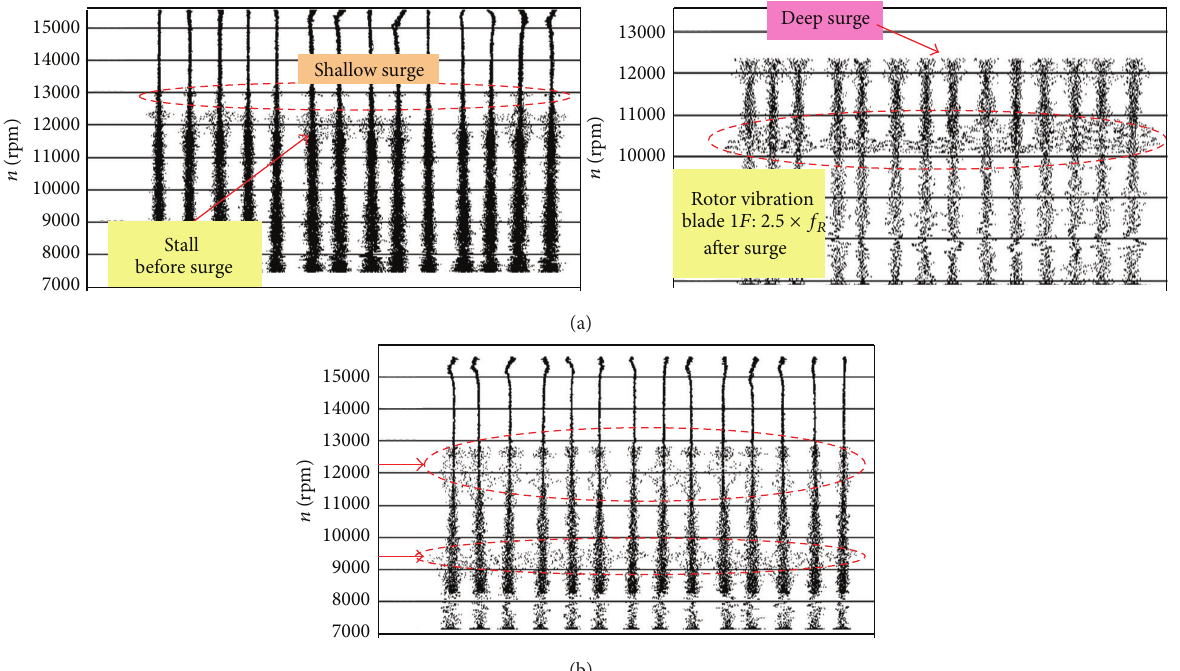
Figure 33: The asynchronous resonance of the compressor blades [55, 61, 63]: (a) before, during, and after the surge; (b) during identification of the surge limit ( 𝑝 3 signal disconnected from FCU).